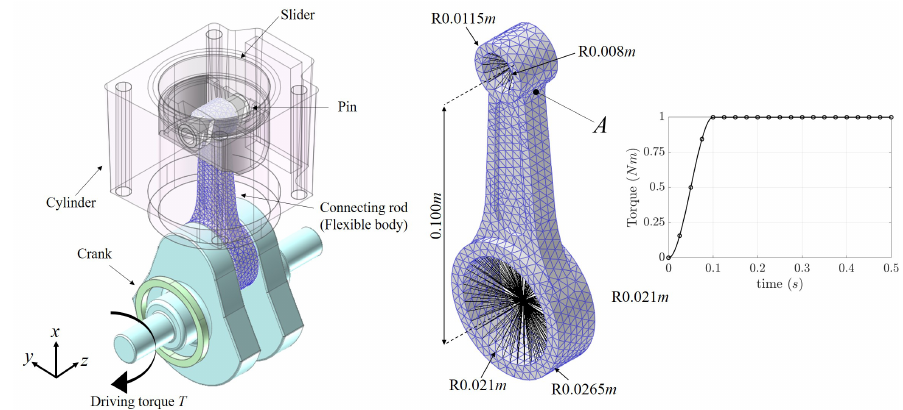
Figure 11. The slider-crank system (left) and the flexible connecting rod (middle). The driving torque with respect to time (right) is imposed to rotate the